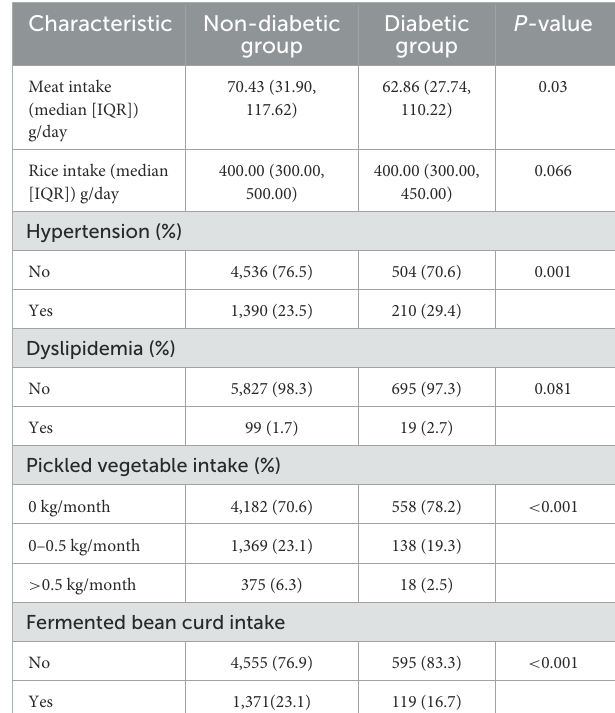
TABLE 2 Adjusted odds ratios for associations of diabetes and pickled vegetable/fermented bean curd intake (treated as categorical